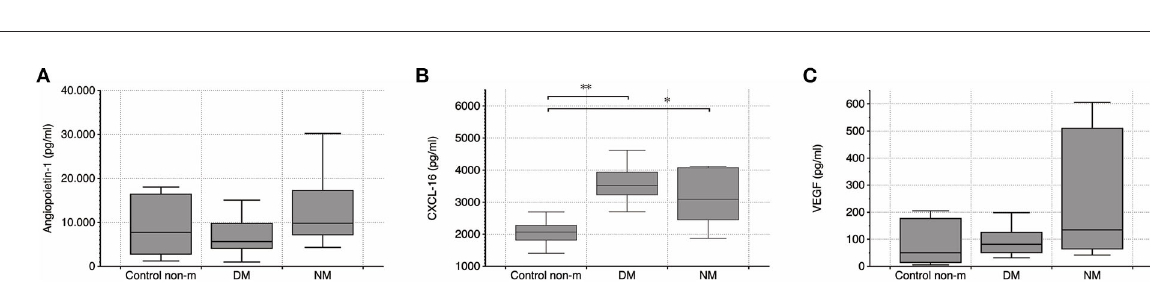
and activation (increased endothelial CXCR6), the endothelial repair machinery is activated but severely affected (CXCL16 elevation, lower eEPC colony formation, constant serum